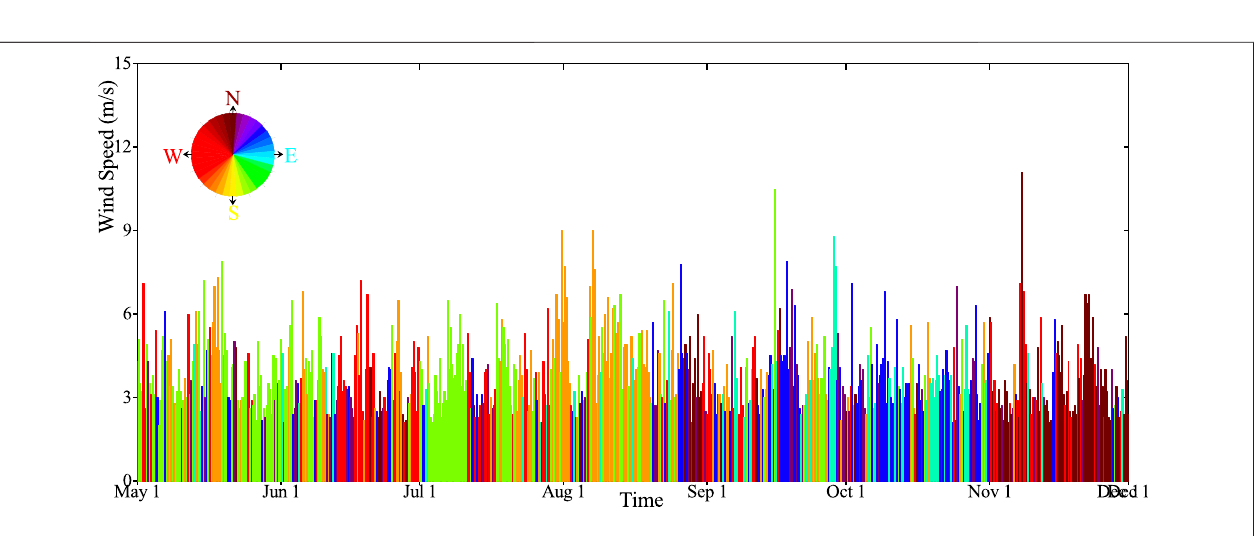
FIGURE 5 | Wind speed and direction during calculation